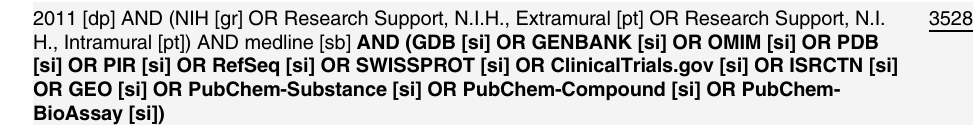
Table 3. PubMed search identifying articles with the “ Molecular Sequence Data ” MeSH Heading (MSD dataset). 2011 [dp] AND (NIH [gr] OR Research Support, N.I.H., Extramural [pt] OR Research Support, N.I. H., Intramural [pt]) AND medline [sb] NOT (GDB [si] OR GENBANK [si] OR OMIM [si] OR PDB [si] OR PIR [si] OR RefSeq [si] OR SWISSPROT [si] OR ClinicalTrials.gov [si] OR ISRCTN [si] OR GEO [si] OR PubChem-Substance [si] OR PubChem-Compound [si] OR PubChem-BioAssay [si])